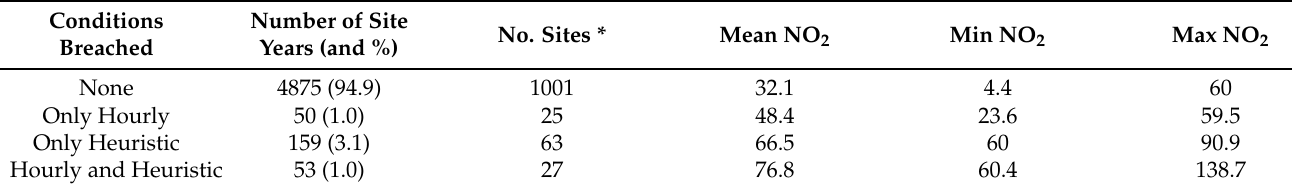
Table 4. Summary of data for “Traffic” sites in the UE dataset, examining the cartesian product of whether the heuristic threshold is met (>60 µ g/m 3 annual mean) and whether the hourly threshold is met (more than 18 h >200 µ g/m 3 ). The last four columns show mean, minimum, maximum, and standard deviation of measured NO 2 for each category (in µ g/m 3 ). * A site can be in more than one set because it can differ from year-to-year and so the total of the column exceeds the total number of sites